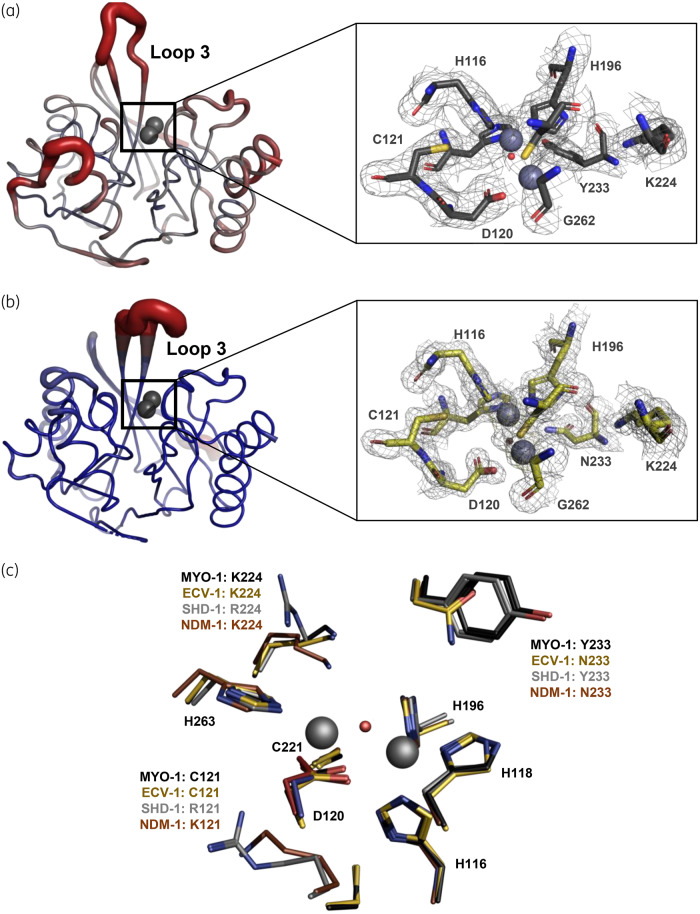
Overall fold of (a) MYO-1 (chain A) and (b) ECV-1 with the crystallographically assigned B values (left), where blue represents low B factors and red represents high B factors (colour code scaling of B factors from 20 to 75 Å2), and their active site amino acids including the corresponding 2Fo-Fc map (right). Temperature factors for MYO-1 were generally higher than for ECV-1. However, both structures showed high variation in their loop 3 region. (c) Active site of MYO-1 (black), ECV-1 (gold) and SHD-1 (grey) superimposed onto NDM-1. The Zn(II) ions are displayed from MYO-1.